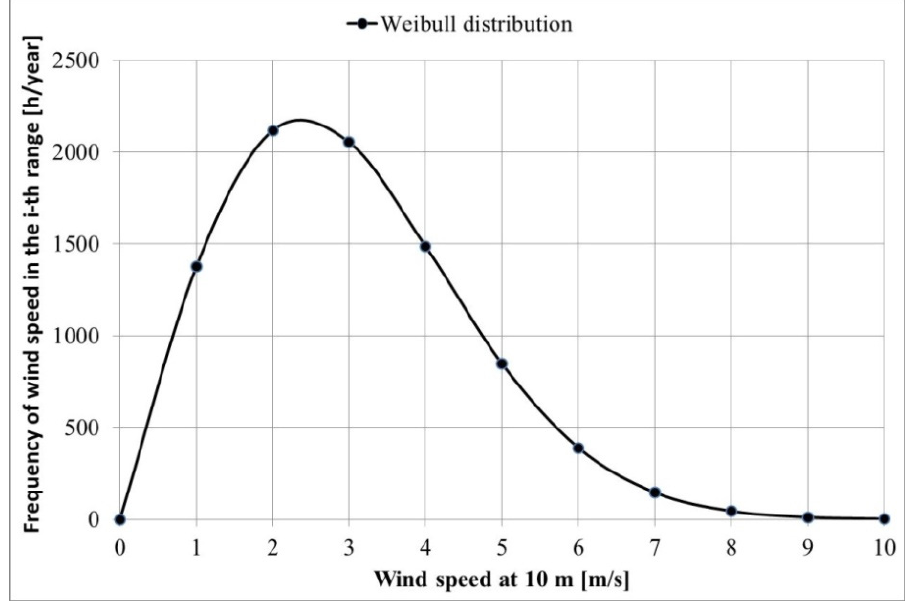
Figure 6. The Weibull distribution for the anemometer at 10 m above ground level for location IIb— airstrip.